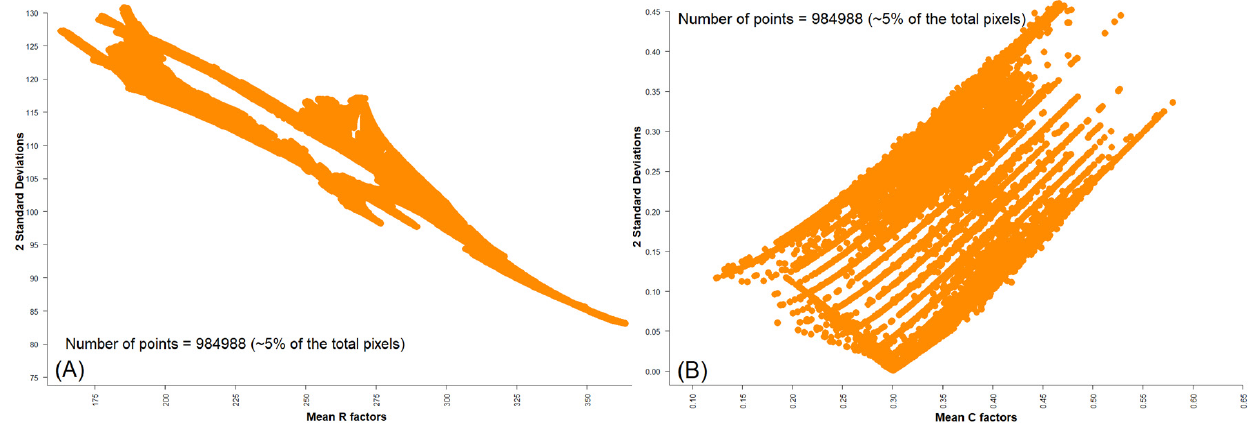
Figure 14. Uncertainty plots show the mean value of the factors estimates (x-axis) against two standard deviations of the factors estimates (y-axis) for ( A ) R factor and ( B ) C factor models. Table 12 emphasizes that the R factor does not play a big role in the discrepancy in the obtained results, especially for the six best scenarios of the RSed, where the same equation (i.e., Equation (5)) was used for Scenarios #18 and #66; Scenario #66 comes